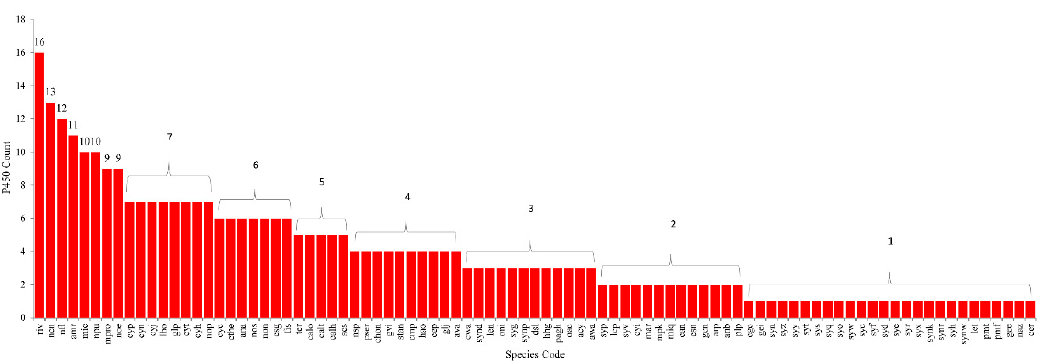
Figure 3. Comparative analysis of P450s in cyanobacterial species. The numbers next to bars indicate the number of P450s in each species. The species names with respect to their codes can be found in Table S2.